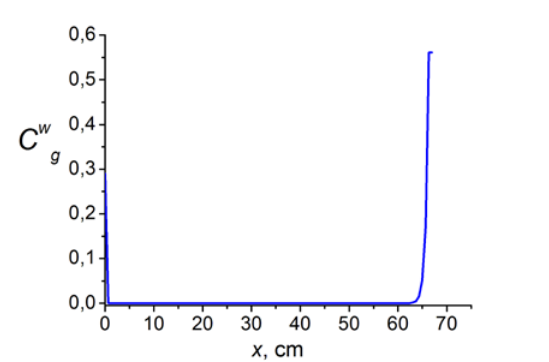
Fig. 9. The concentration of water steam in the gas phase in the heatpipe effect problem.